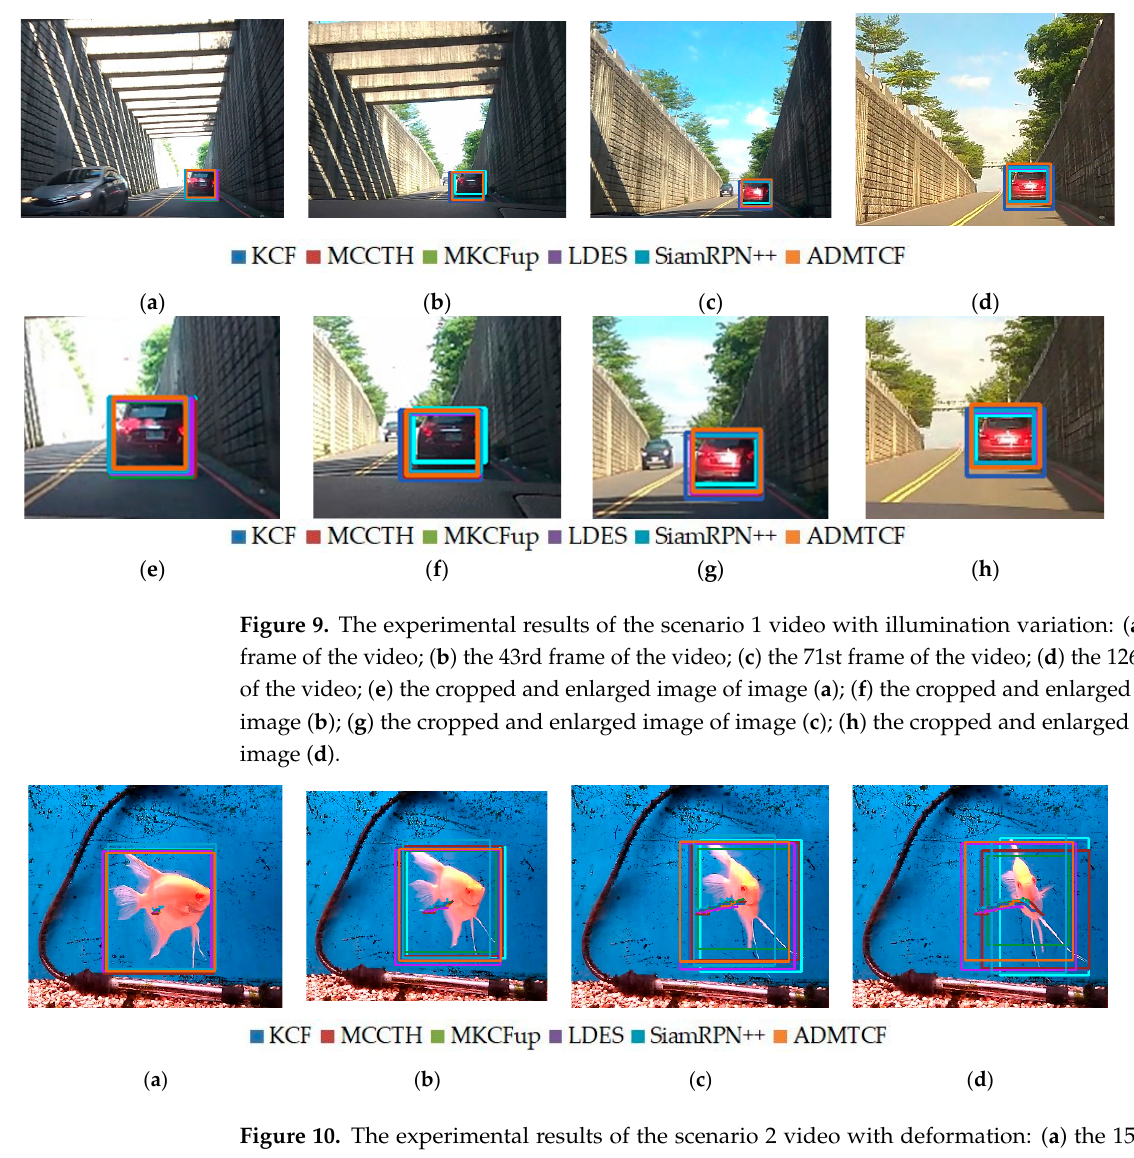
Figure 8. There are two overlap conditions: ( a ) the first overlap condition; ( b ) the other overlap condition.